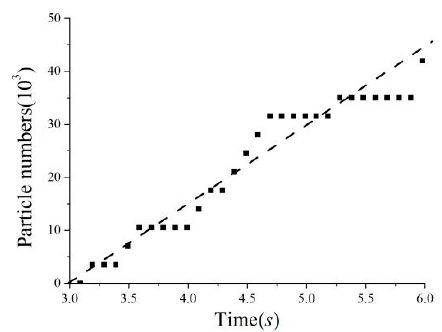
Figure 7. The total number of particles deposited on the solar panel.